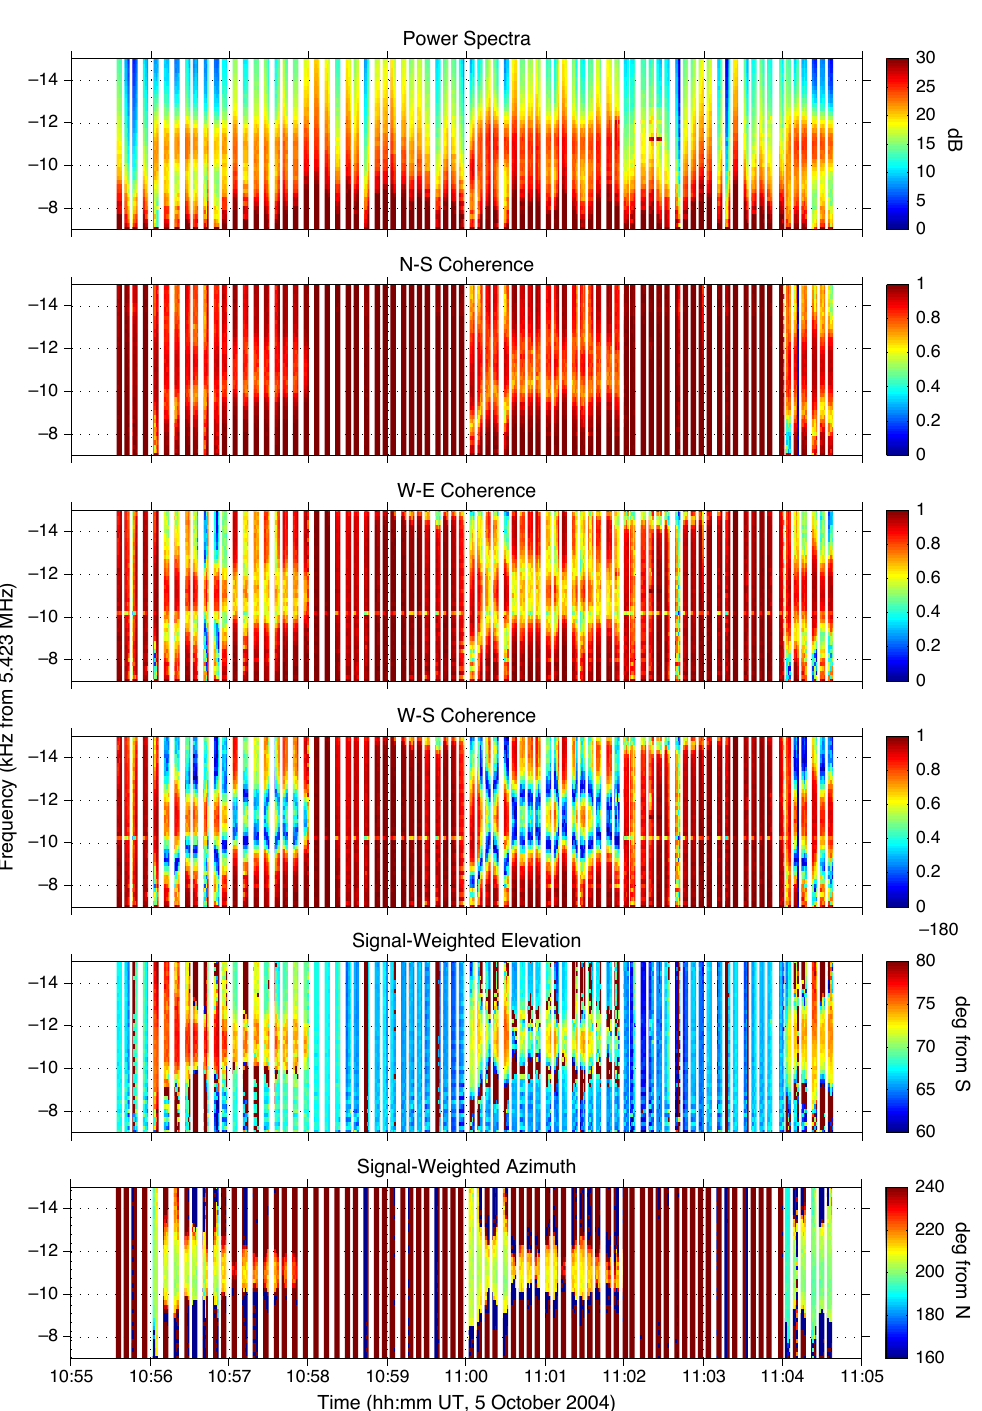
Isham et al. Figure 14 Fig. 14. SEE interferometer data from 5 October 2004 at EISCAT on Ramfjordmoen. This is the same time period as in Fig. 12 but with an expanded view of the portion of the frequency scale encompassing the DM, and showing the power spectrum, the coherences for all three antenna baselines, plus elevation and azimuth angles computed for the DM source region. The DM can be seen between about − 10 and − 12kHz relative to the pump frequency. The elevation angle of the DM is about 77 ◦ during the pump cycle beginning at 10:56 UT and about 73 ◦ during the follow two cycles. Time and frequency resolutions are 1s and